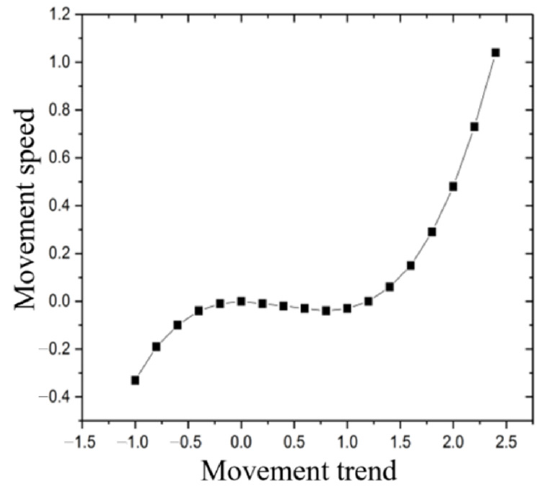
Figure 2. The potential function simulation diagram.